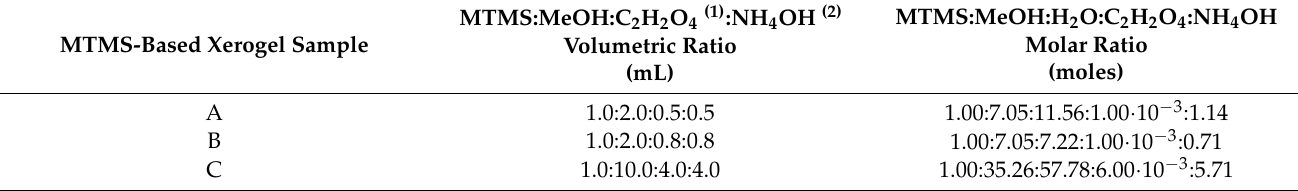
Table 3. Molar and volumetric ratios applied in xerogel